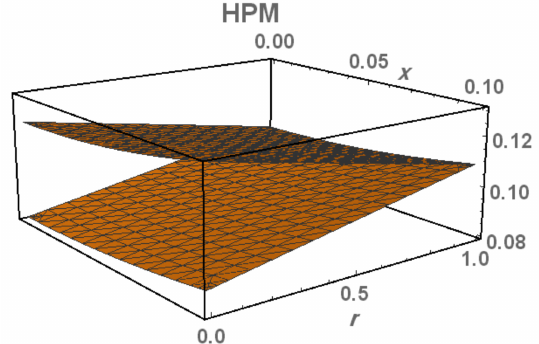
Figure 5. Solution using the fifth-order double parametric fuzzy HPM at t = 0.1, b = 0.2,0.8 for all x ∈ [ 0,0.1 ] and r ∈ [ 0,1 ] .